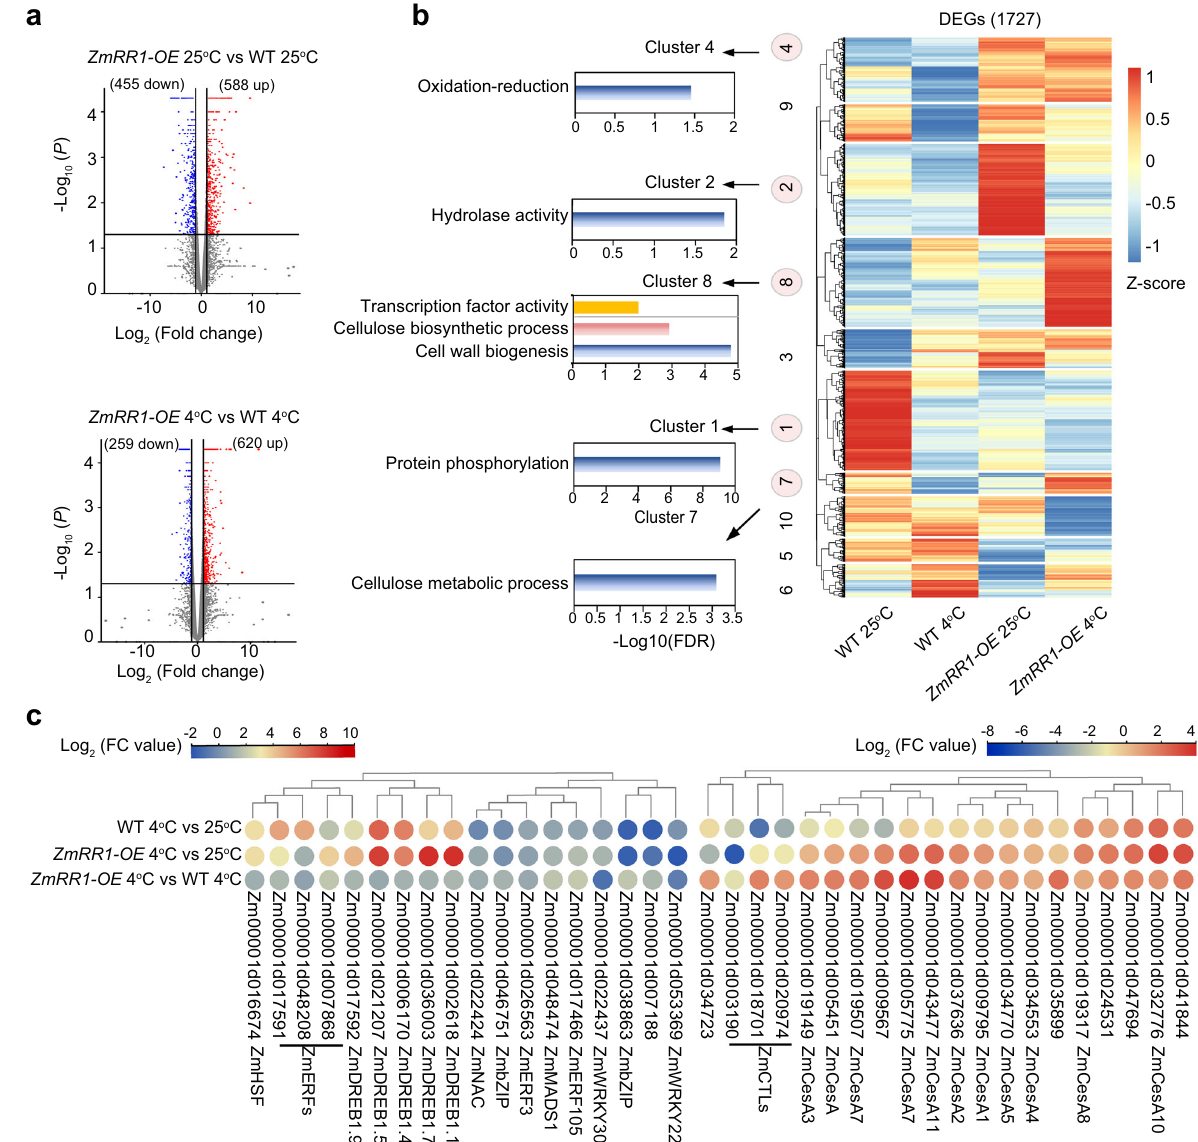
Fig. 5 Transcriptome analysis of ZmRR1 -regulated differentially expressed genes. a Volcano plots showing the number of differentially expressed genes (DEGs) regulated by ZmRR1 at 25 and 4 °C. DEGs were identi fi ed using P value < 0.05 and absolute log2-fold change > 1 as criteria. b Hierarchical clustering and heatmap of 1727 ZmRR1-regulated DEGs and Key GO Terms. DEGs show segregation into 10 co-expressed clusters. The z-score scale represents mean-subtracted regularized log-transformed FPKM. Full results of GO enrichment analysis of heatmap DE clusters are shown in Supplementary Data 2. c Heatmap showing the DE transcription factors and cell-wall biogenesis related genes regulated by ZmRR1. Colors represent log2- fold change comparing relative